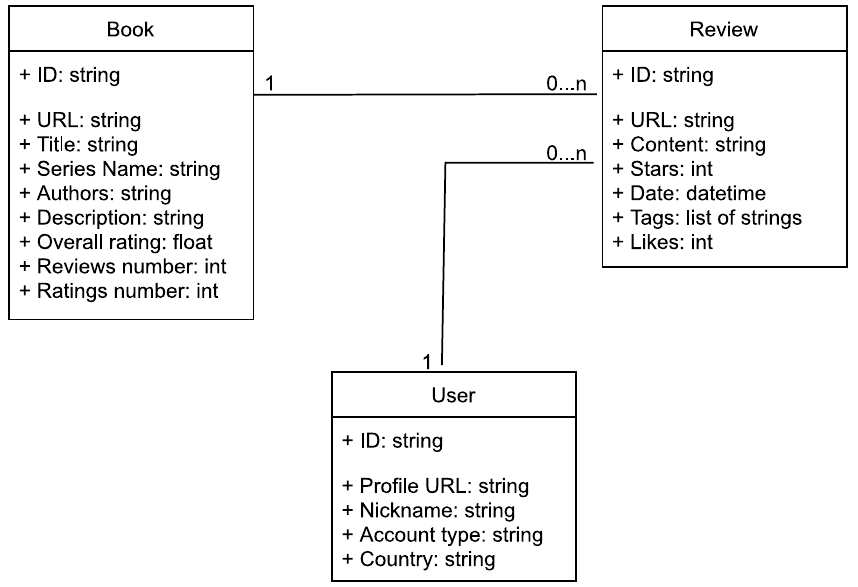
Figure 2. Entity and their relationships on Goodreads Web pages.